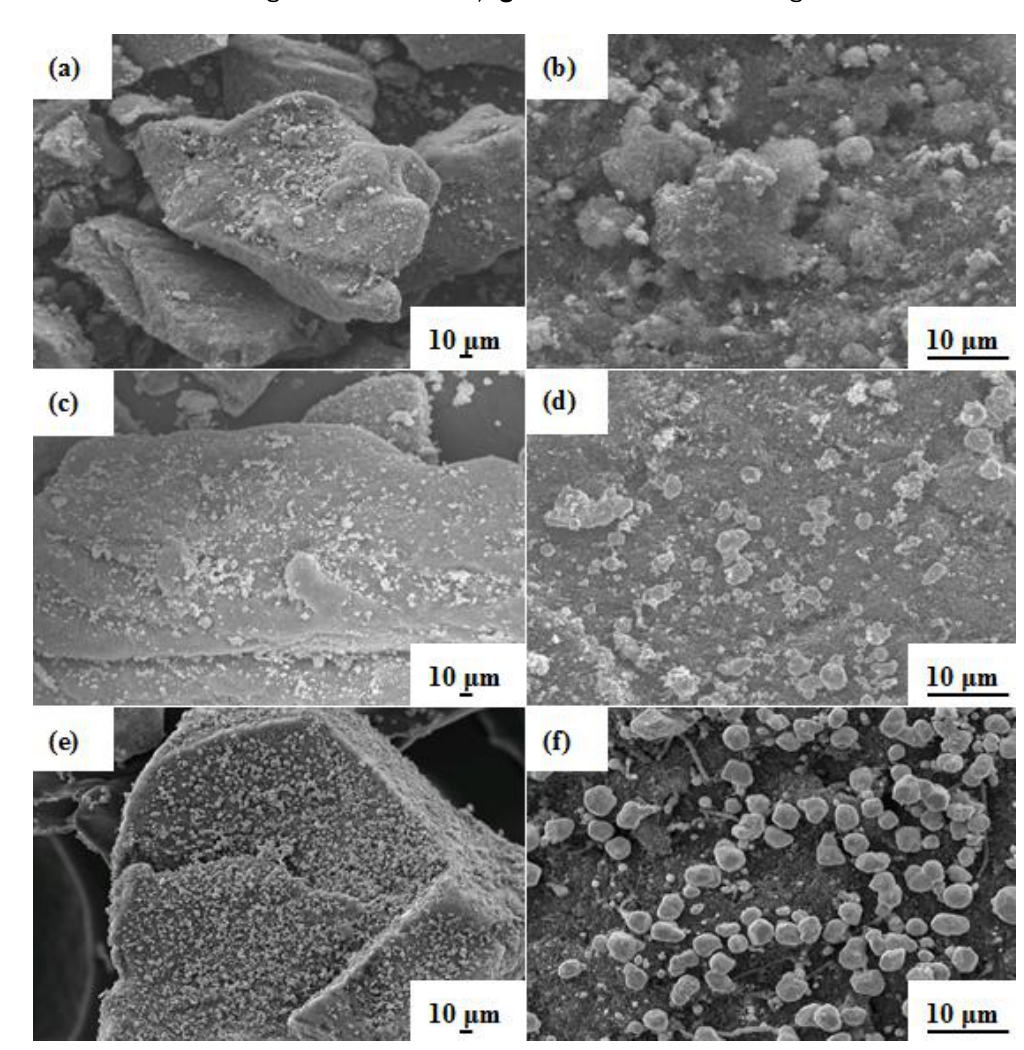
Figure 4. SEM images of silver particles on BC at 120 °C for various reduction times as ( a ) 0.5 X and ( b ) 2 X magnification of 1 h; ( c ) 0.5 X and ( d ) 2 X magnification of 2 h; ( e ) 0.5 X and ( f ) 2 X magnification of 3 h; ( g ) 0.5 X and ( h ) 2 X magnification of 4